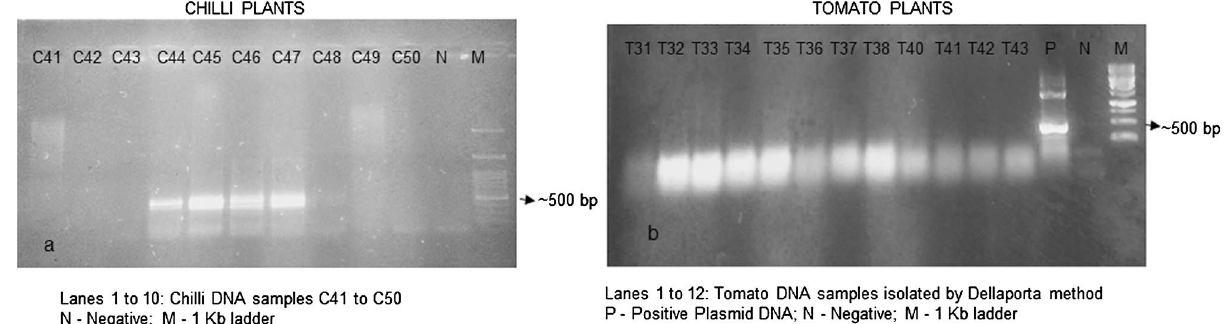
Figure 2. Screening of plants for the presence of begomovirus by PCR using Deng primers (Deng et al., 1994). ( a ) Lanes 1 to 10: Chilli DNA samples C41 to C50; N—Negative; M—1 Kb DNA ladder. ( b ) Lanes 1 to 12: Tomato DNA samples isolated by Dellaporta method; P positive plasmid DNA; N negative; M—1 Kb DNA ladder.